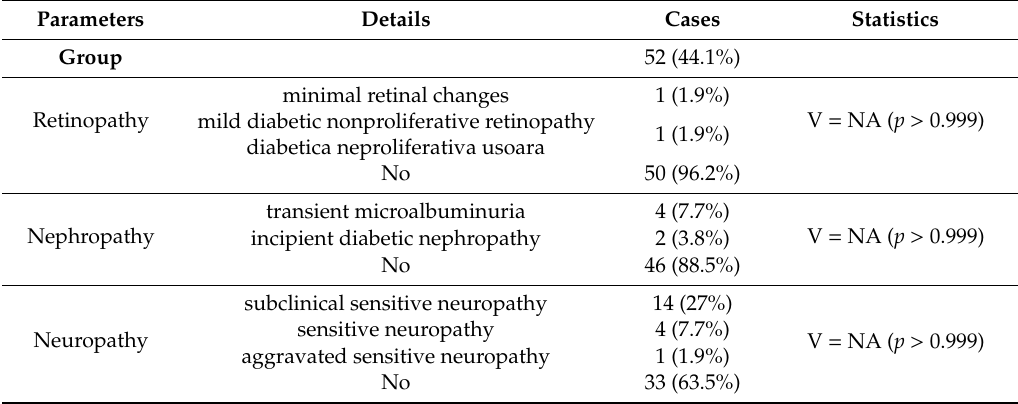
Table 7. Complications in diabetic